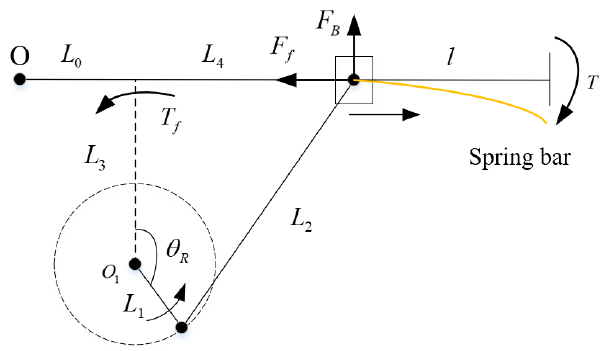
Figure 11. Schematic diagram of resistance moment.